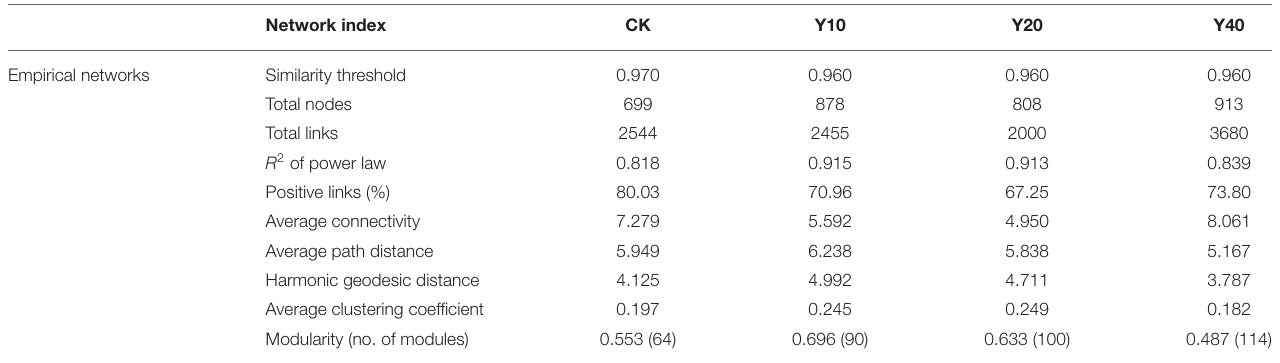
TABLE 5 | Major topological features of the molecular ecological networks of bacterial communities in CK, Y10, Y20, and